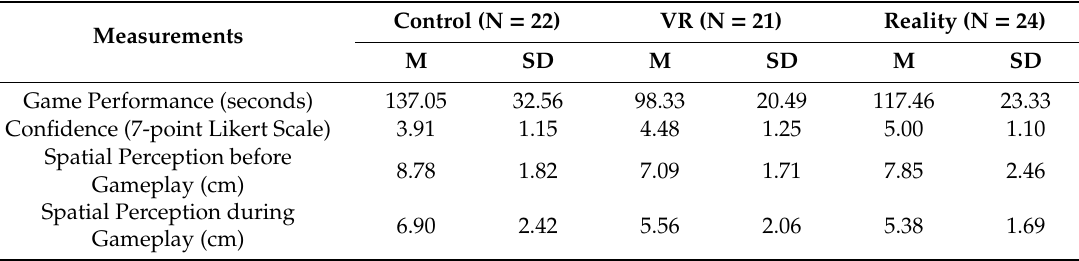
Table 1. Summary of